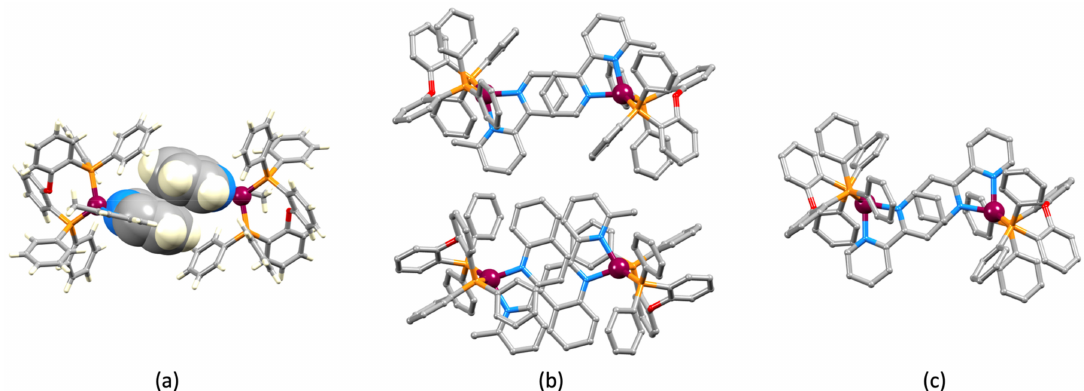
Figure 11. ( a ) Dimeric motif in the solid-state structure of [Cu(POP)(6-Mebpy)][PF 6 ] (CSD refcode BOSVAI), and ( b ) the same motif viewed from above, compared with the analogous packing unit in [Cu(POP)( 2 )][PF 6 ] (H atoms omitted). ( c ) Centrosymmetric packing motif in the solid-state structure